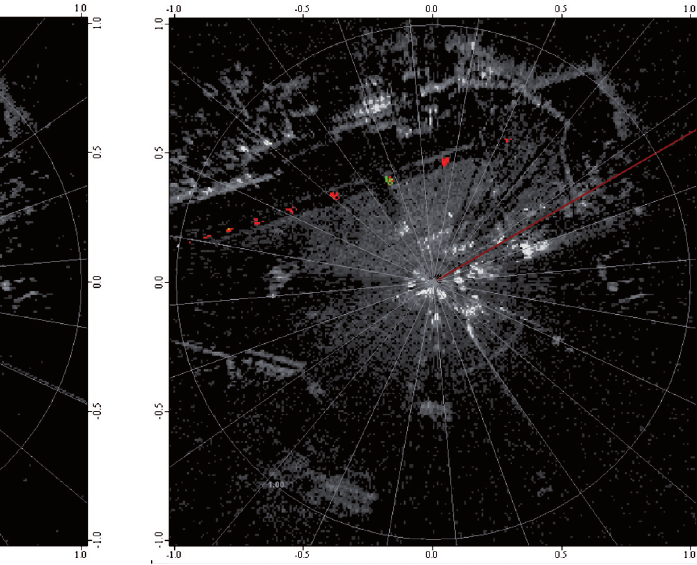
Fig. 4. The radar image of part of the airport area with an Antonov-12 plane